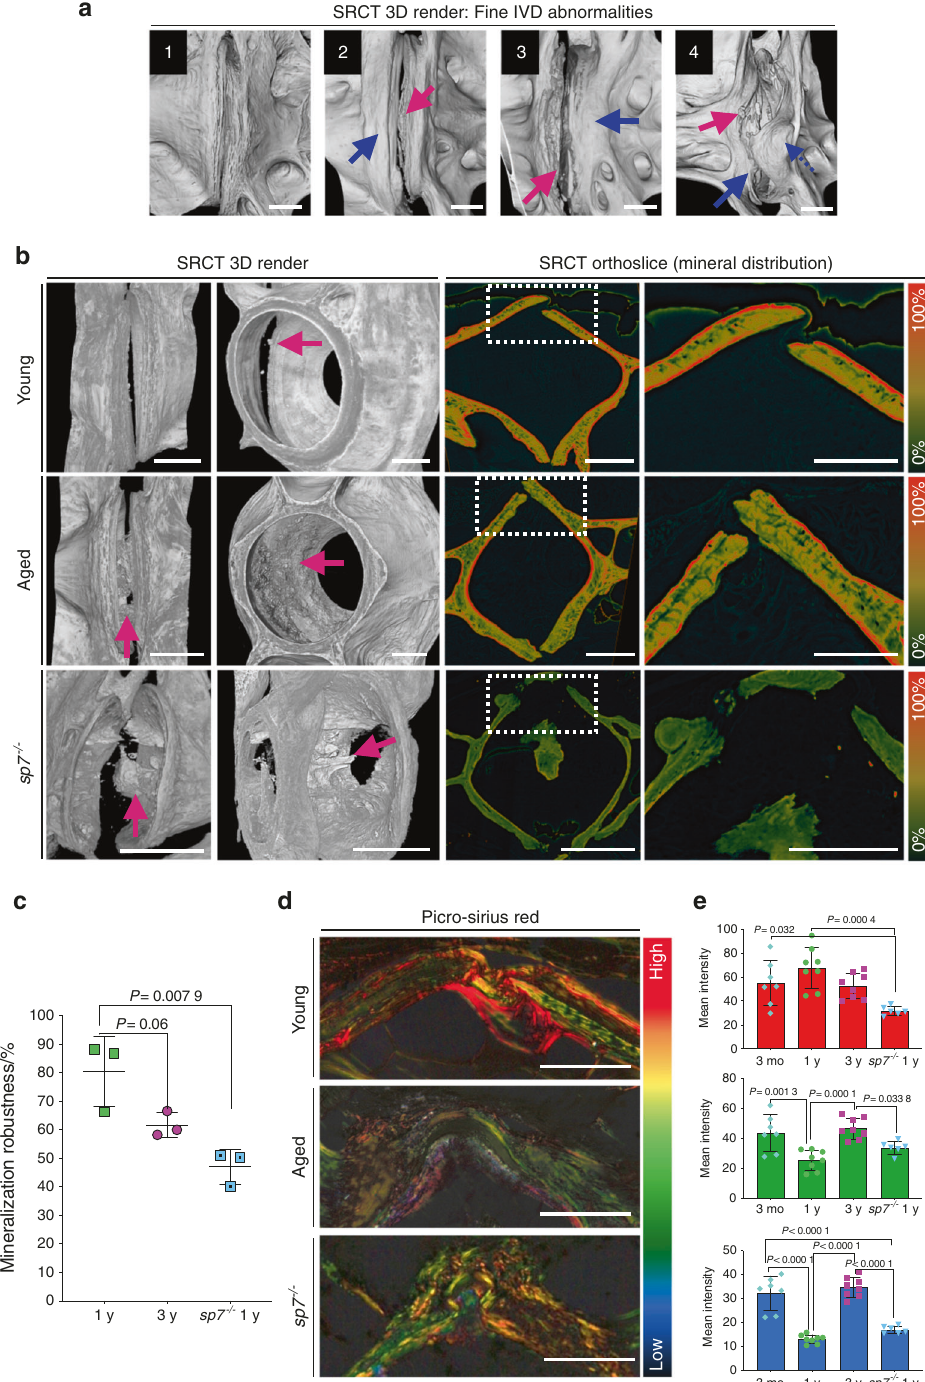
Fig. 3 SRCT reveals subtle bone morphological abnormalities and alterations in mineral density distribution. a 3D volumetric rendering from μ CT images showing fi ne endplate abnormalities. 1: normal IVD; 2: endplate sclerosis (blue arrow) and IVD calci fi cation (pink arrow); 3: sclerosis (blue arrow), uneven edges and AF calci fi cation (pink arrow); 4: sclerosis (blue arrow), AF calci fi cation (pink arrow); osteophyte (dashed blue arrow). Scale bars = 50 μ m. b 3D volumetric rendering from μ CT images showing IVD internal changes in aged and sp7 − / − zebra fi sh. Calci fi cation depicted by pink arrow (SRCT 3D rendering). Note, young zebra fi sh with IVD and disc misalignment shows points of IVD calci fi cation. Virtual sections (orthoslices) color coded for bone density (SRCT orthoslice). Dashed box regions are magni fi ed and displayed on the right. Scale bars = 50 μ m. c Quanti fi cation of mineralization robustness (%) in wt young (1 y), wt aged (3 y), and sp7 − / − 1 y zebra fi sh ( n = 3 per group, average from 4 sections per fi sh). One-way ANOVA and post hoc Holm – Sidak ’ s multiple comparisons test were used; data are the mean and SD. P values are indicated. d Paraf fi n sections stained with picrosirius red showing the thickness of collagen fi bers (thin = blue/ green and thick = red/orange). Scale bars = 50 μ m. e Quanti fi cation of collagen fi ber thickness from picrosirius red staining (blue = thin, green = medium, red = thick) (1 y, n = 8; 3 y, n = 8; 3 months, n = 7; sp7 − / − 1 y, n = 6; we analyzed three sections per fi sh). One-way ANOVA, post hoc Tukey ’ s multiple comparisons test; data are the mean and SD. P values are